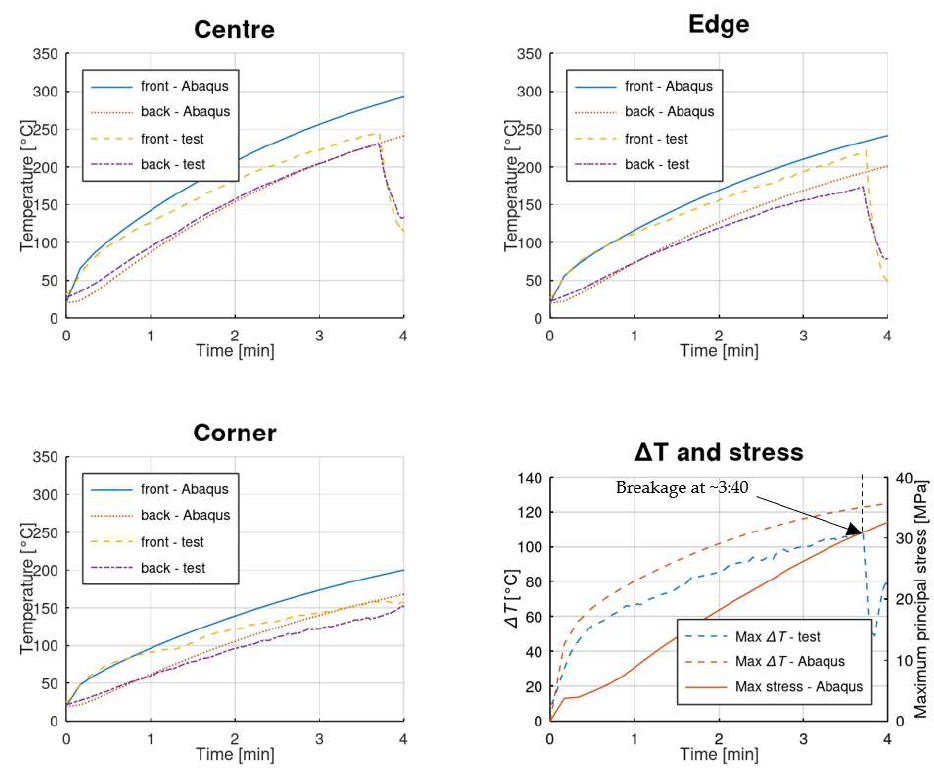
Figure 20. 3D model vs test results for 6 mm thick glass pane (Test #7).